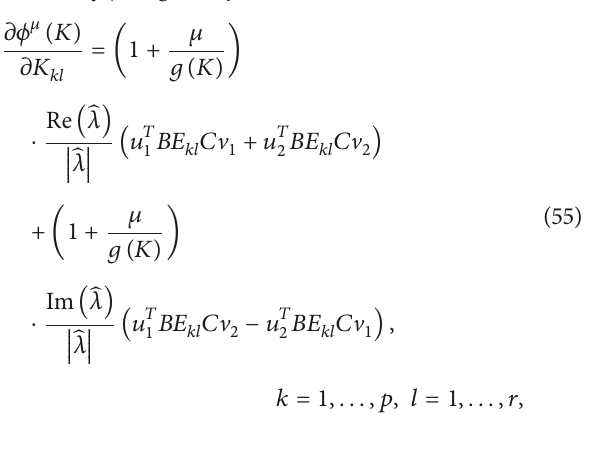
Algorithm 17 (logarithmic barrier method for the